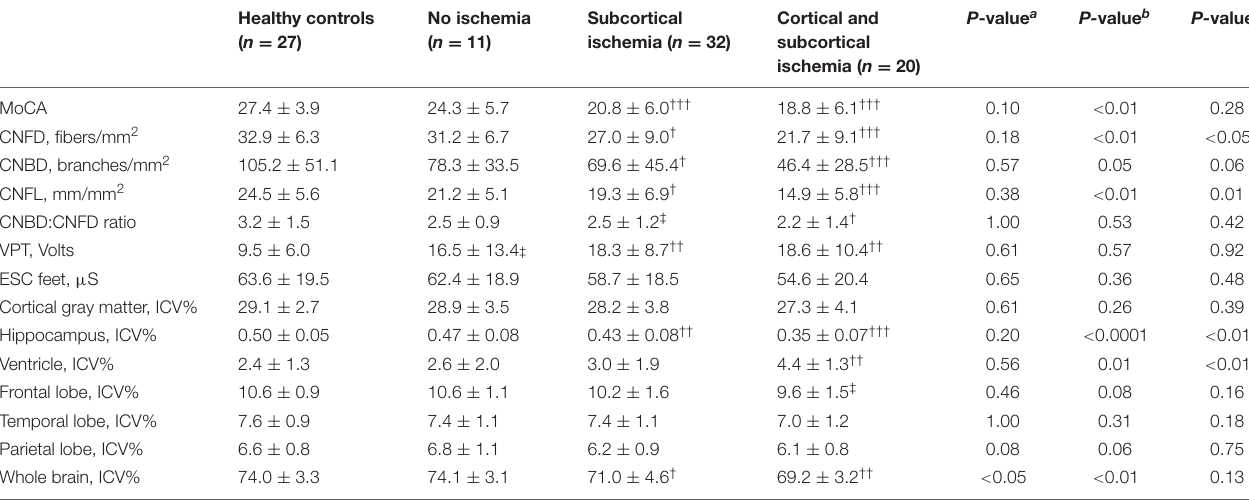
TABLE 2 | Comparison of cognitive function, corneal nerve fiber morphology and volumetric brain MRI between healthy controls and no ischemia, subcortical ischemia and both cortical and subcortical ischemia in subjects with MCI and dementia. Healthy controls No ischemia Subcortical Cortical and ( n = 27) ( n = 11) ischemia ( n = 32) subcortical